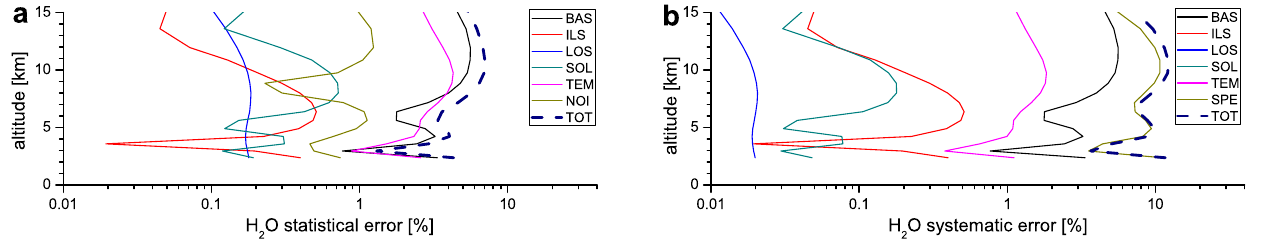
Fig. 5. H 2 O profile errors as estimated for Iza˜na from the uncertainty assumptions of Table 2 for the typical situation of 26 October 2011. (a) statistical errors; (b) systematic errors. The acronyms in the legend correspond to the acronyms of Table 2; TOT represents the root-square-sum of all errors.